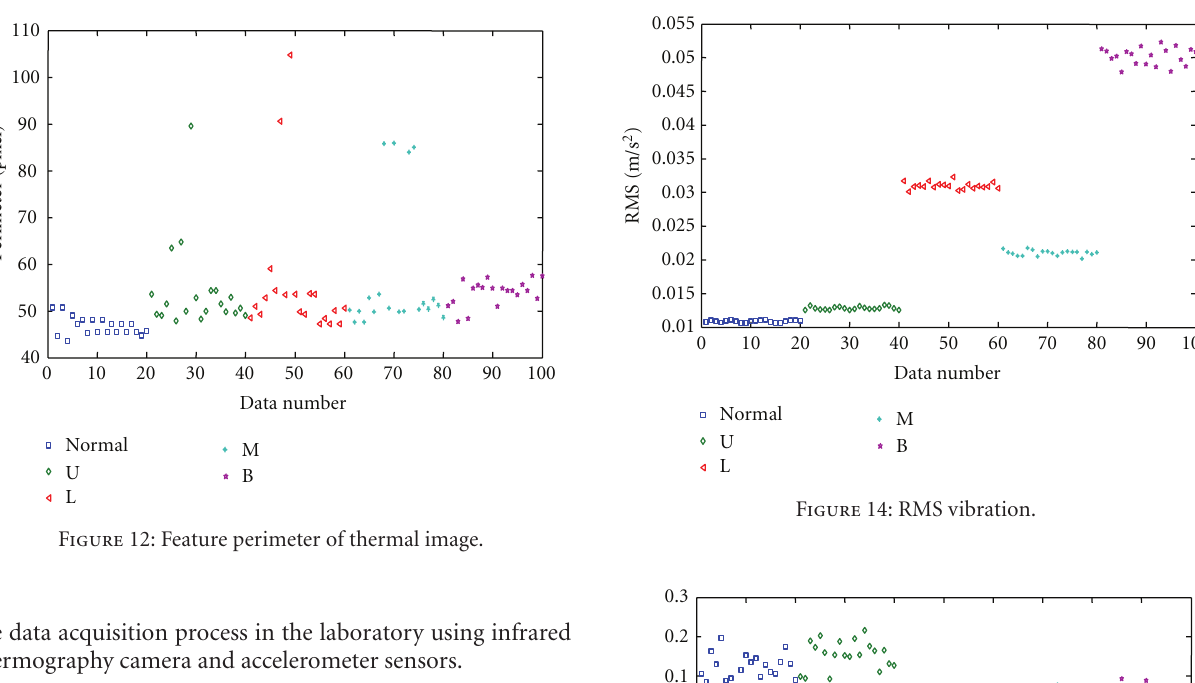
Figure 11: Feature area of thermal image.